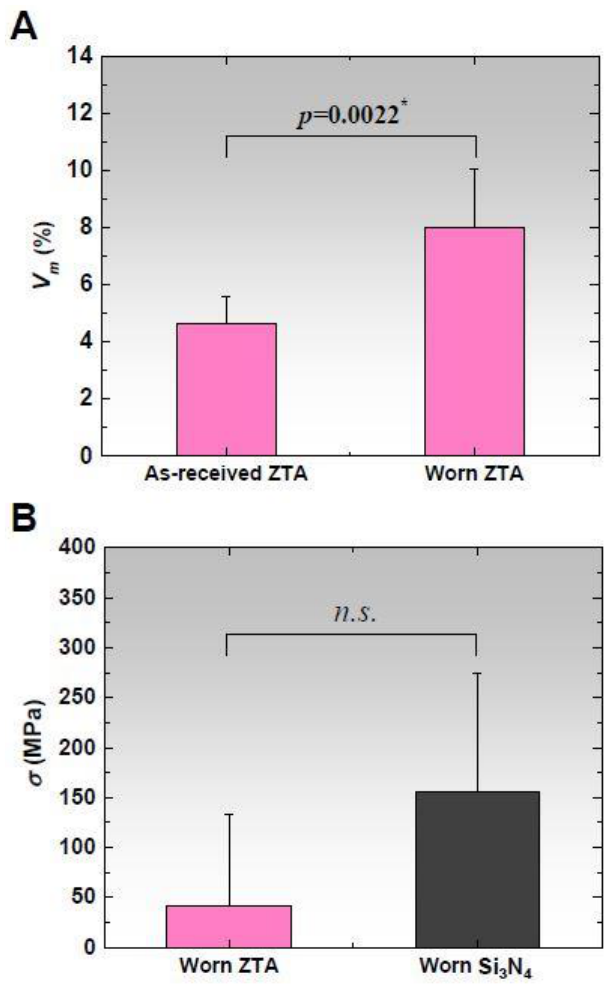
Figure 5. ( A ) Comparison of surface percentages of tetragonal-to-monoclinic phase transformation ( V m ) between the as-received (unworn) and worn ZTA heads; and ( B ) comparison of surface residual stress ( σ ) after wear between ZTA and Si 3 N 4 . The asterisks and n.s. represent p < 0.05 and p > 0.05,